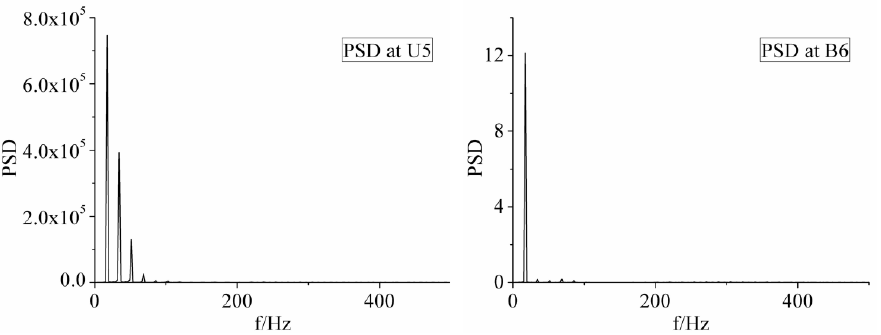
Figure 15. Acoustic power spectral density at U5 and U6 for σ = 0.65.